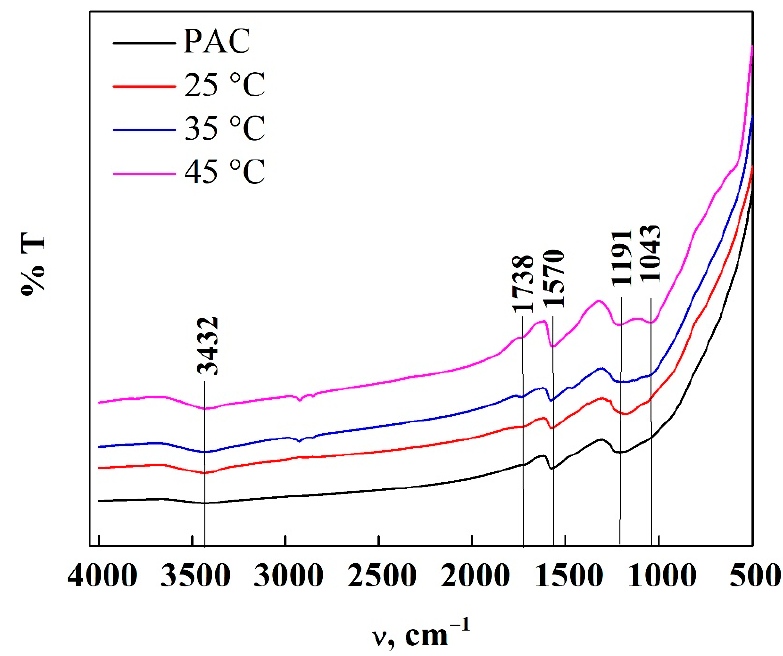
Figure 6. ATR-FTIR spectra of PAC before and after adsorption.